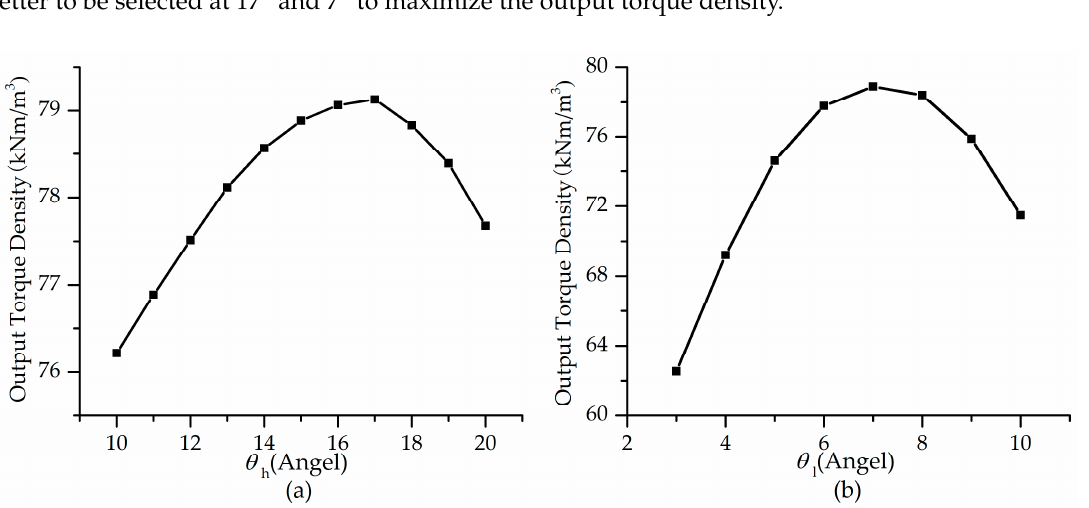
Figure 8. Output torque and effective torque density curves versus R in .